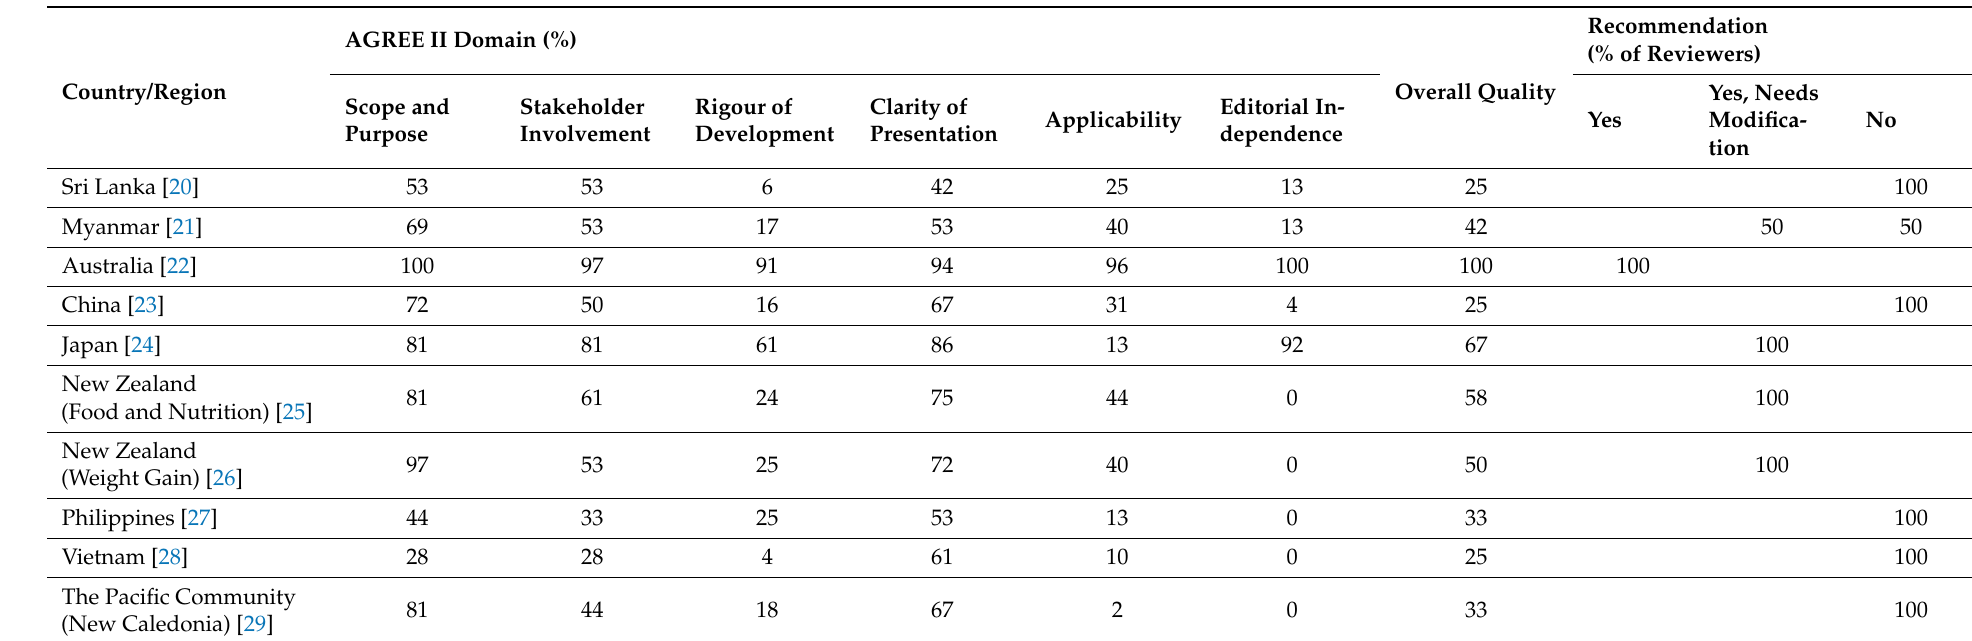
Table 3. Critical appraisal of the CPGs on GWG and maternal nutrition using AGREE